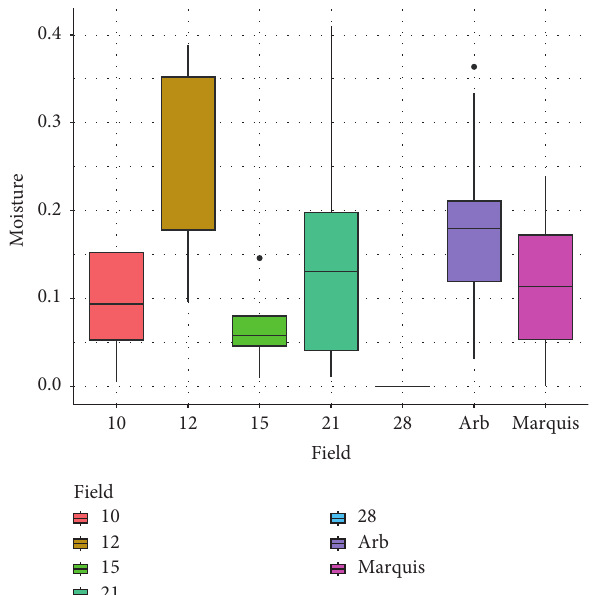
Figure 3: Comparison of soil moisture percentages by field.